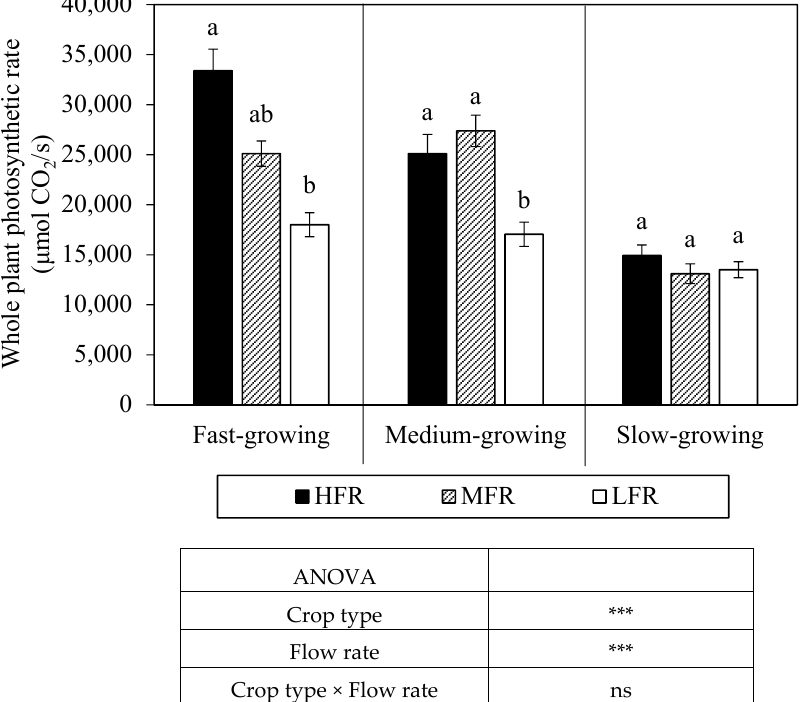
Figure 6. Whole plant photosynthetic rate of fast ‐ growing (Chinese cabbage, lettuce), medium ‐ growing (mustard, chia), and slow ‐ growing (basil, Swiss chard) crops in aquaponics as affected by high (HFR, 3.3 m/day), medium (MFR, 2.2 m/day), and low (LFR, 1.1 m/day) flow rate. The same letter within the same plant category is not significantly different based on Tukey’s honestly significant difference test ( α = 0.05). Data represent the mean of 18 replicates ± SE. ns, *, **, *** mean no significant or significant at p ≤ 0.05, 0.01, or 0.001, respectively.